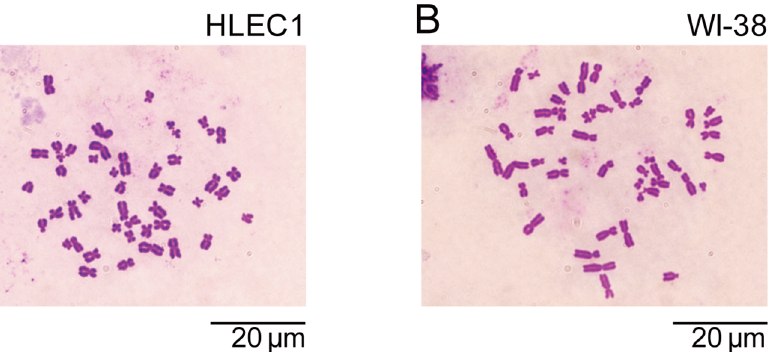
Figure 1. Representative images of metaphase chromosomes in HLEC1 at CPD 14.5 (A) and WI-38 at CPD 44.7 (B). Bars, 20 m m.